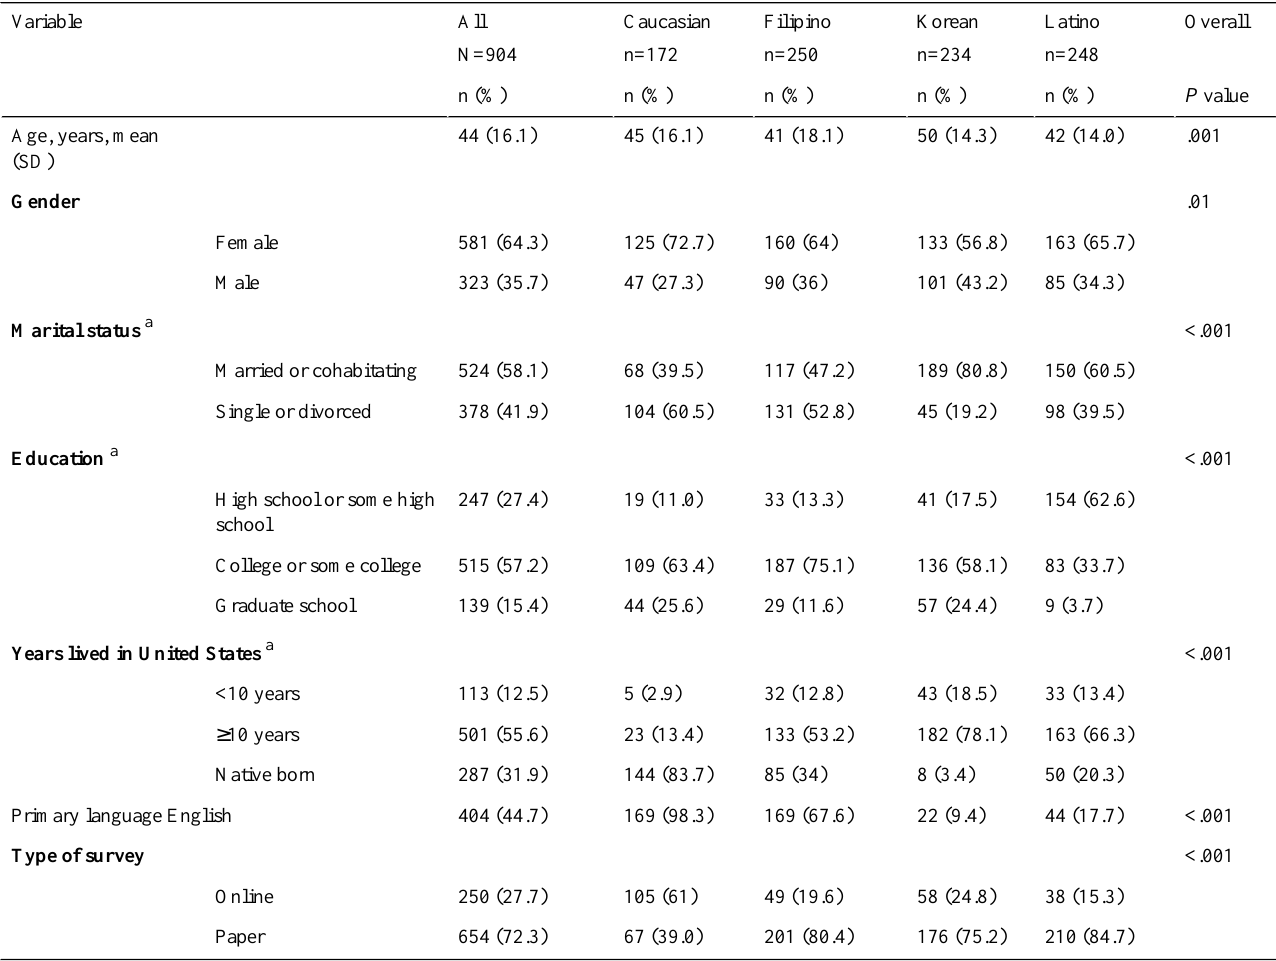
Table 1. Demographics and digital technology characteristics by race/ethnic